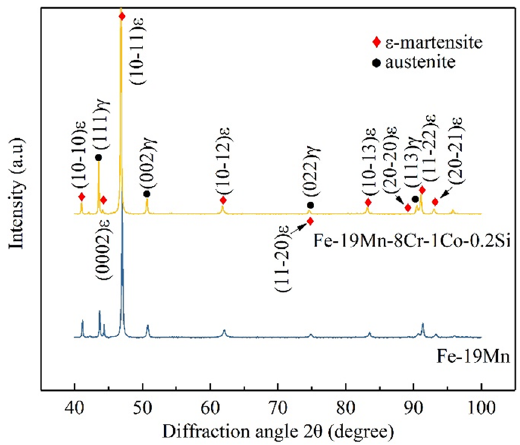
Figure 3. XRD patterns of the Fe-19Mn and Fe-19Mn-8Cr-1Co- 0.2Si alloys after solution treatment. The TEM micrographs of the Fe-19Mn and